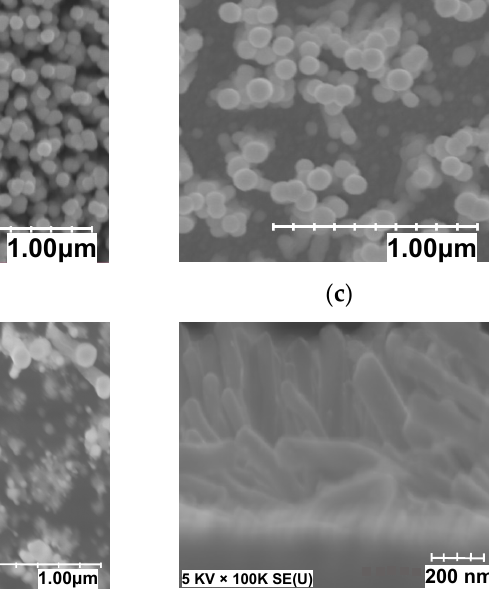
4 of 17 Figure 1. Schematic diagram of the gas testing equipment. 3. Results and Discussion 3.1. Characterization There are different ways to change the number of tubes per area in vertically aligned CNT such as varying the catalyst vapor concentration [26], pressure [27], time [28], and temperature [29]. In this study, we obtained different densities of fibers by changing the H 2 /C 2 H 2 gas ratio in the CNF growth process [30], where H 2 was fixed at 700 sccm. At a flow of about 5 sccm of acetylene gas, the nanofibers are not fully vertically aligned and intertwine. As shown in Figure 2, by increasing the gas flow up to 20 sccm, an increase in density was observed, and the tube alignment improved. For the gas sensing measure-